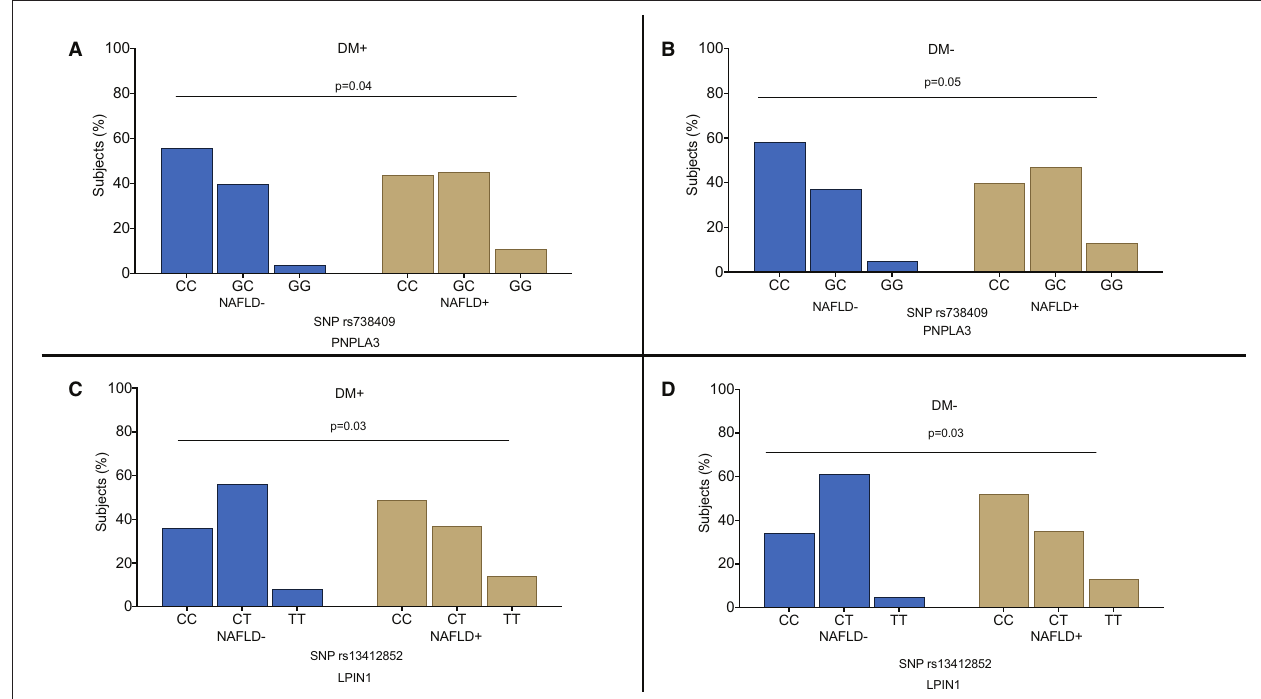
FIGURE 2 | Distribution of the genotypes in the diabetic patients (A–C) and non-diabetic individuals (B–D) according to the presence of non-alcoholic fatty liver disease (NAFLD). DM + : patients with type 2 diabetes; DM − : non-diabetic individuals.